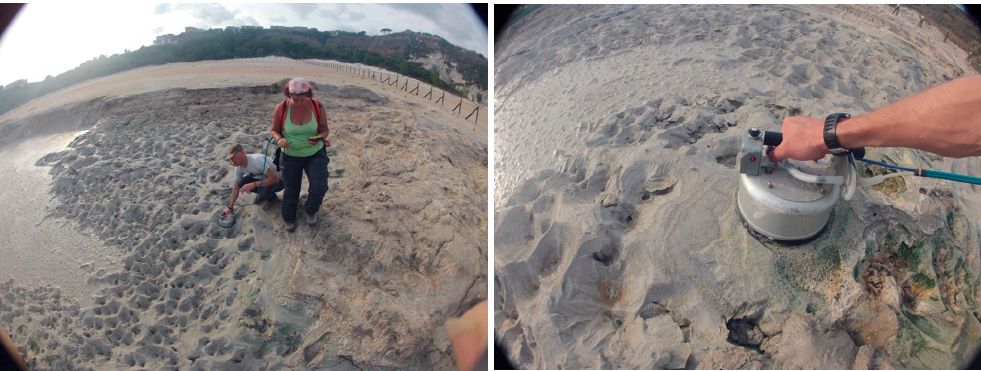
Figure 7. Direct CO 2 flux measurements (accumulation chamber method by [31]) across the dry section of the Fangaia basin. Note the funnel-shaped vent structures.